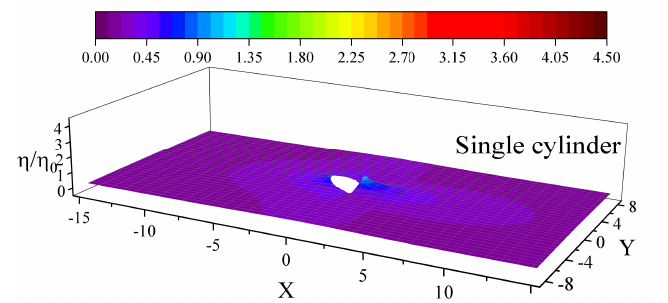
Figure 8. The scattered-wave elevation of single cylinder at k 0 a =